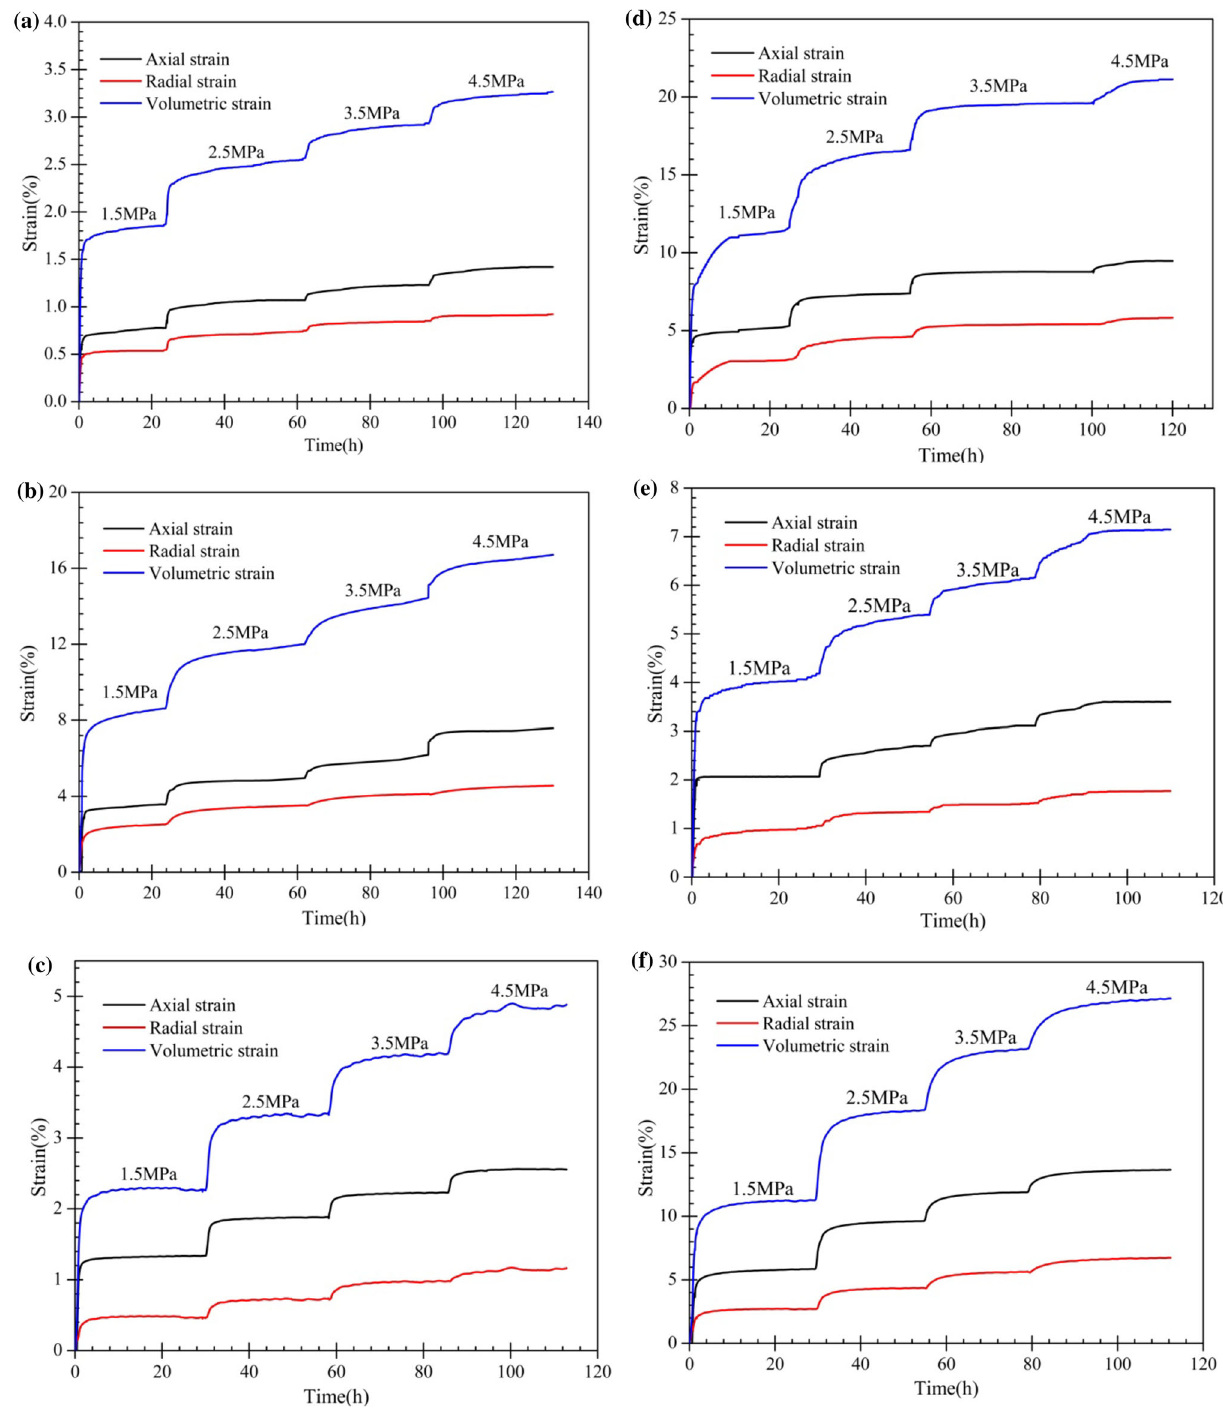
Fig. 8 Creep testing curves under different stress levels: a Jingle laterite specimens with 1.0 mm wide cracks, b Baode laterite specimens with 1.0 mm wide cracks, c Jingle laterite specimens with 1.5 mm wide cracks, d Baode laterite specimens with 1.5 mm wide cracks, e Jingle laterite specimens with 2.5 mm wide cracks, f Baode laterite specimens with 2.5 mm wide